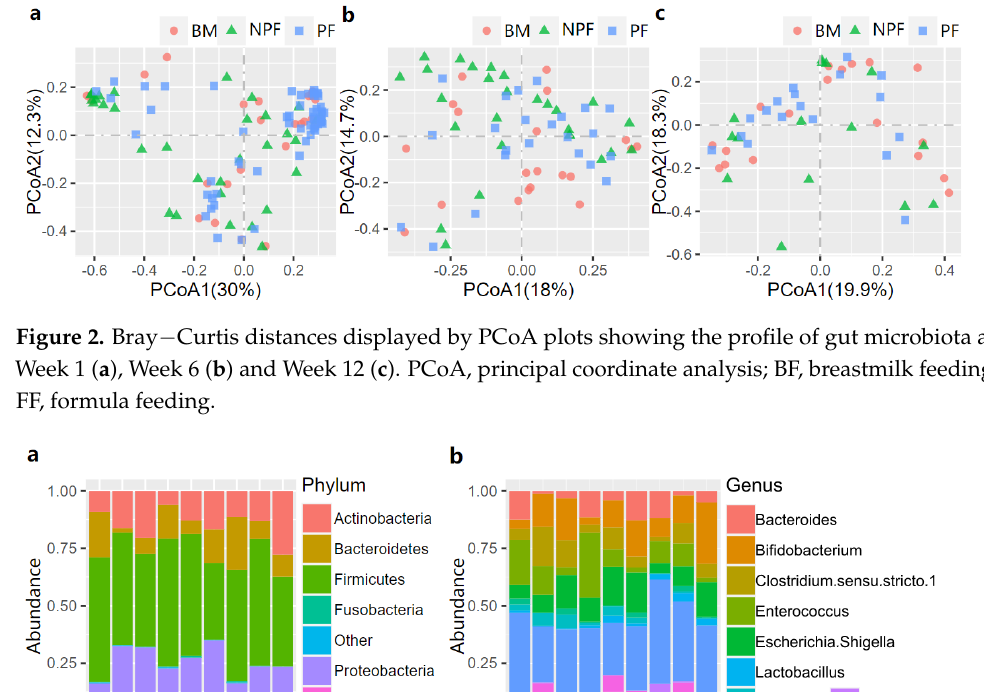
Figure 2. Bray − Curtis distances displayed by PCoA plots showing the profile of gut microbiota at Week 1 ( a ), Week 6 ( b ) and Week 12 ( c ). PCoA, principal coordinate analysis; BF, breastmilk feeding; FF, formula feeding.